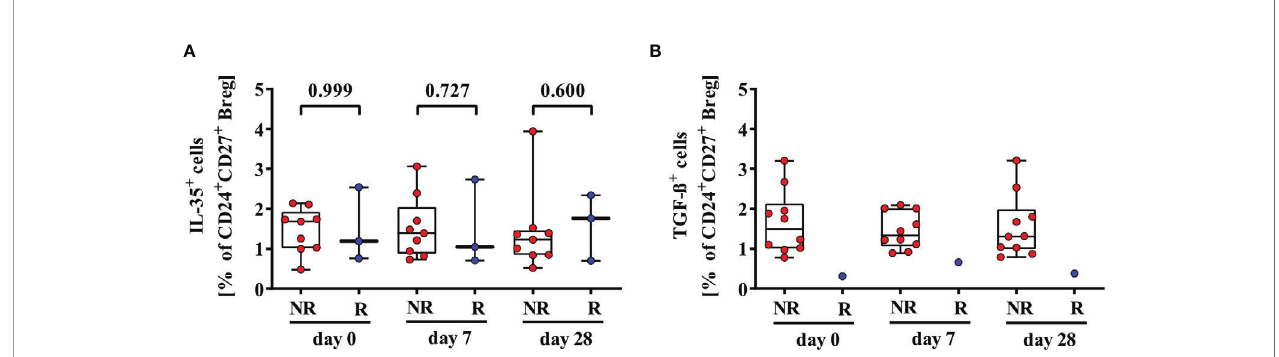
FIGURE 3 | Comparison of frequencies of CD24 + CD27 + IL-35 + (A) and CD24 + CD27 + TGF-ß + (B) Breg of second-generation hepatitis B vaccine non-responders and responders. Depicted are (CpG+P/I)-induced frequencies of CD24 + CD27 + IL-35 + (A) and CD24 + CD27 + TGF-ß + (B) Breg of second-generation hepatitis B vaccine non-responders (NR, red circles) and second-generation hepatitis B vaccine responders (R, blue circles) before (day 0) and 7, and 28 days after vaccination with a third- (NR group) or second- (R group) generation hepatitis B vaccine, respectively. The boxes show the median and the 25 th and 75 th percentile. Whiskers indicate the highest and lowest values. Statistical analyses were done with unpaired Mann-Whitney U tests.